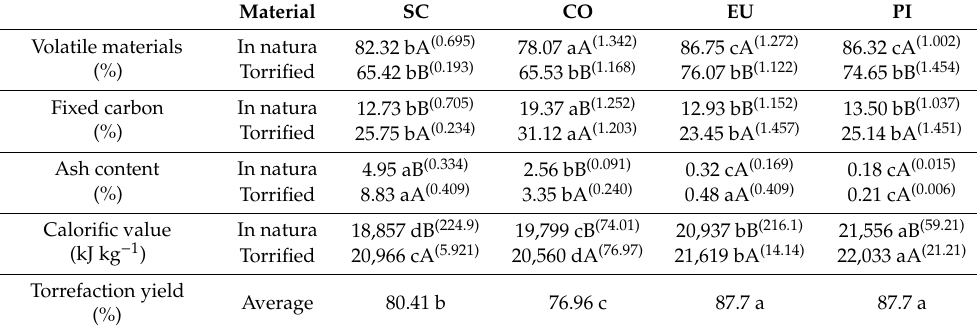
Table 1. Volatile materials, fixed carbon, ash content, calorific value, and torrefaction yield of the sugarcane (SC), Co ff ea arabica (CO), Eucalyptus spp. (EU) and Pinus spp. (PI) biomasses wastes with di ff erent heat